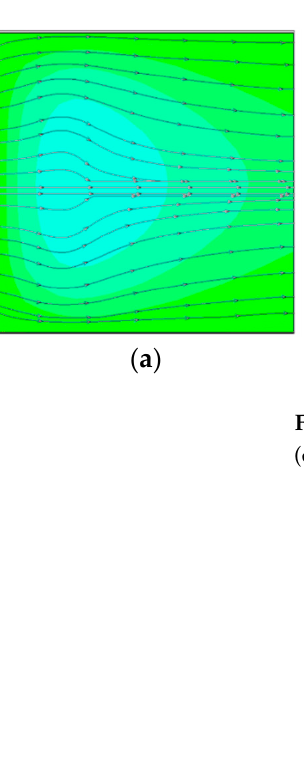
Figure 4. Streamwise velocity along seven vertical lines at a center vertical section for different meshes.